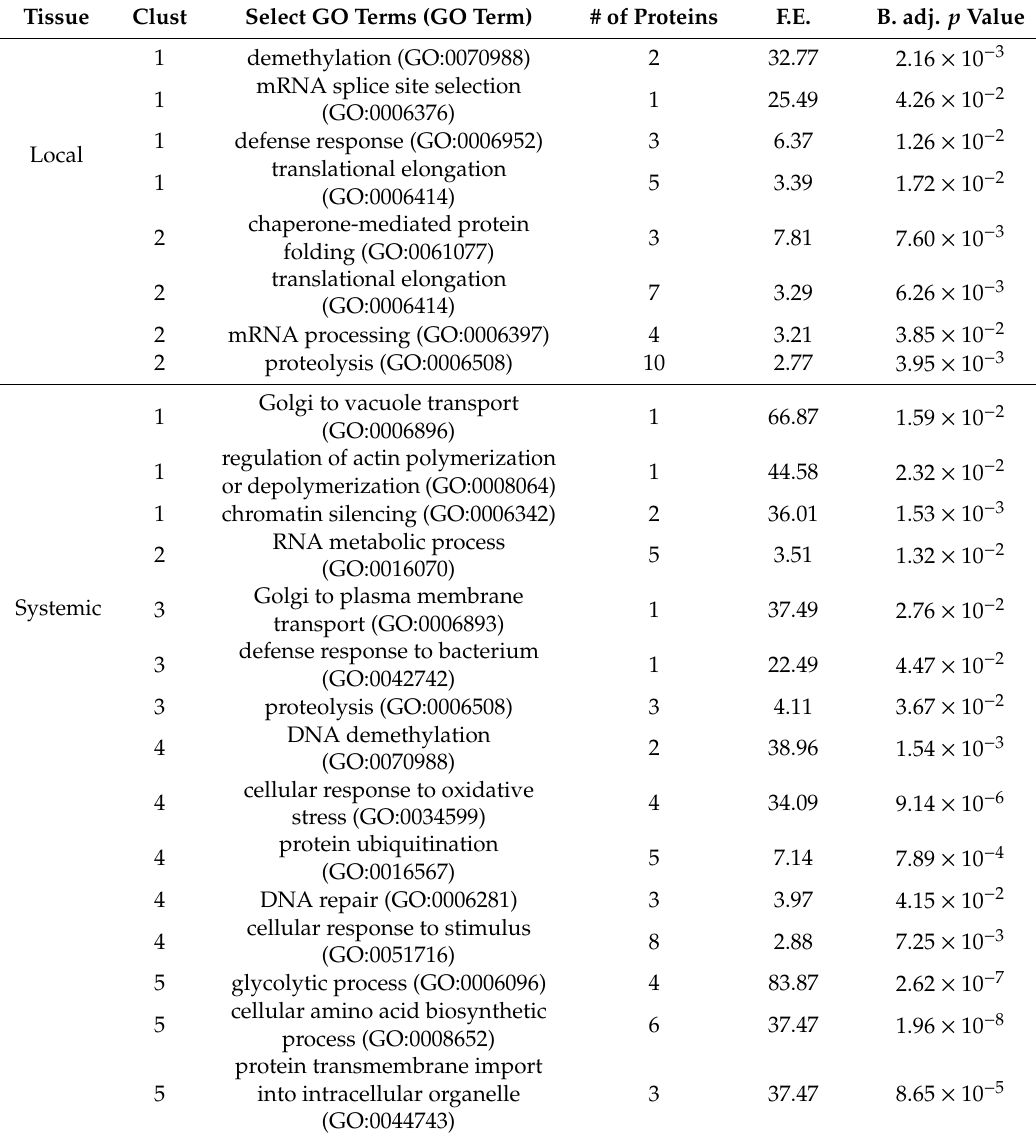
Table1. Selectgeneontology(GO)termsenrichedamonghierarchicalclusteringanalysis(HCA)clusters.